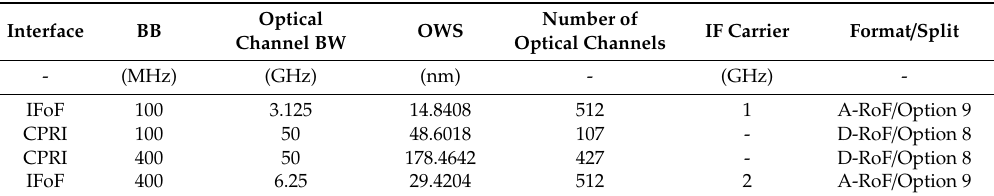
Table 7. Calculated comparative parameters for detailed scenario No. 5 to switch from D-RoF to A-RoF format (the optical channel count-down is starting from wavelength equal to 1675 nm)—Figures 9 and 12 (128-element antenna-array and 4-sector unit).